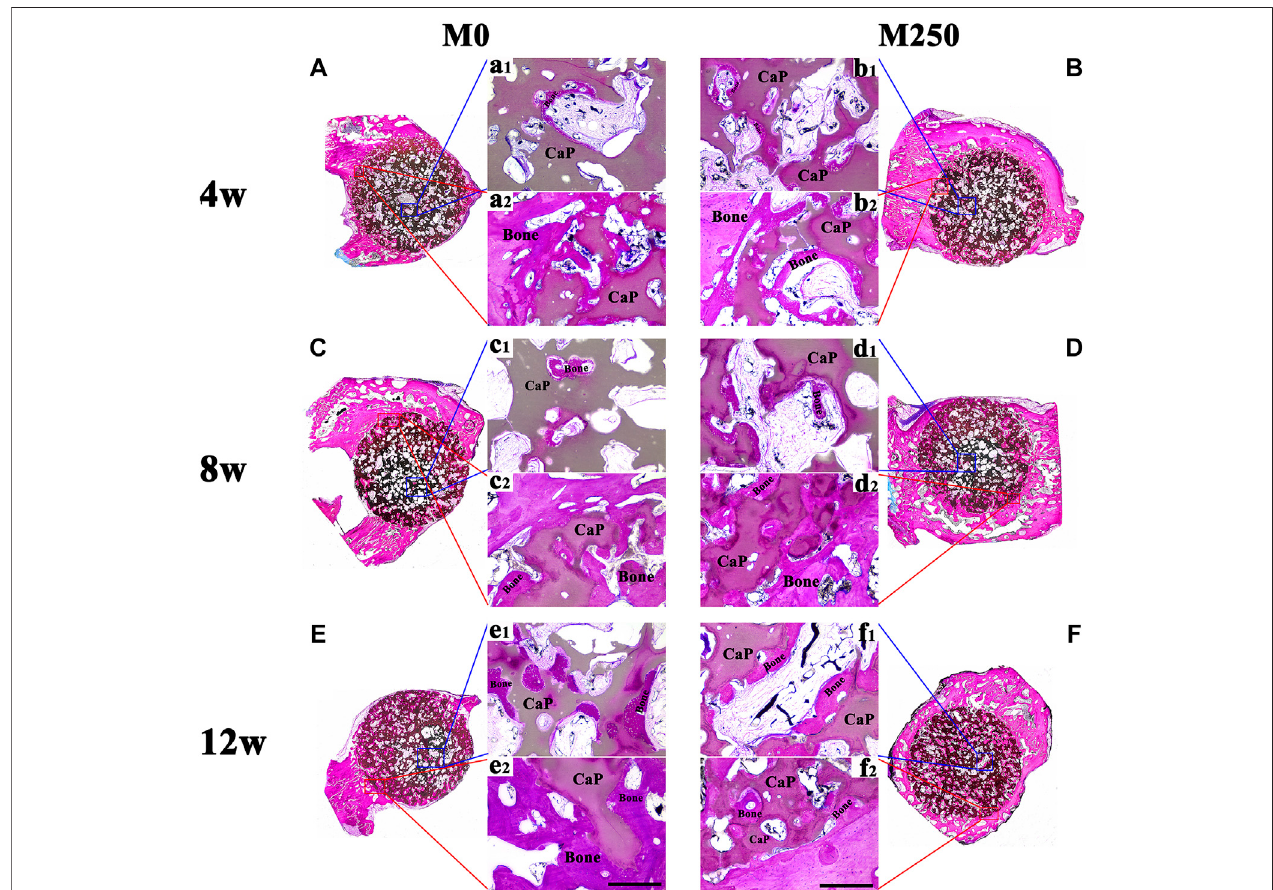
FIGURE 8 | The axial direction histological observation of M0 and M250 after calvarial implantation for 4, 8 and 12 weeks (A), (C), (E) The histologicaloverviews of M0 (B), (D), (F) The histological overviews of M250 (a 1 ) (c 1 ) (e 1 ) New bone islands within the M0 scaffolds pores (b 1 ) (d 1 ) (f 1 ) New bone islands within the M250 scaffolds pores (a 2 ) (c 2 ) (e 2 ) New bone tissue crawl into the M0 scaffolds (b 2 ) (d 2 ) (f 2 ) New bone tissue crawl into the M250 scaffolds (scale (cid:2) 500 µm), Bone: bone tissue; CaP: CaP ceramic.